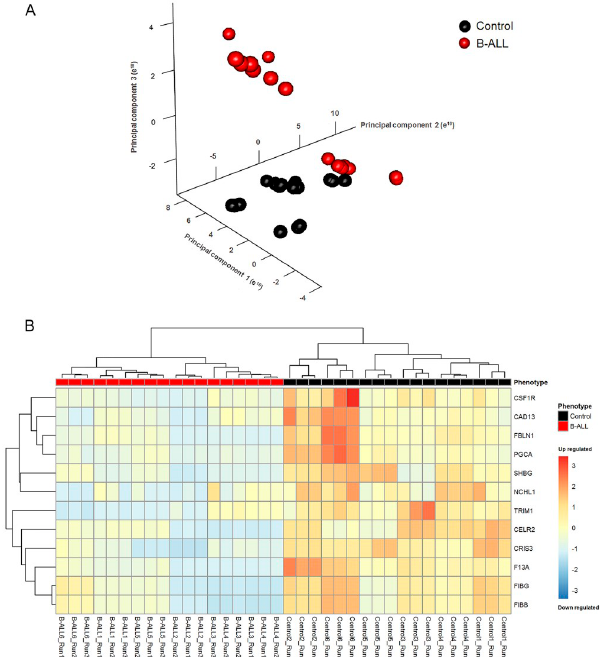
Fig 2. ROTS statistics. A. Unsupervised principal component score plot for controls and B-ALL patients. Red and black bubbles represent B-ALL and control plasma samples, respectively. The analysis resulted in a good separation between groups according to the principal component 1 (PC1) with 64,56% of explained variance, principal component 2 (PC2) 18,39% and principal component 3 (PC3) with 11,92%. B. Heat map of unsupervised clustering of the patients (columns) across the 12 proteins detected as differentially expressed by ROTS (rows), with a Bonferroni- adjusted P-value < 0.05 and a fold change > 3. Red and black bars represent B-ALL and control plasma samples,